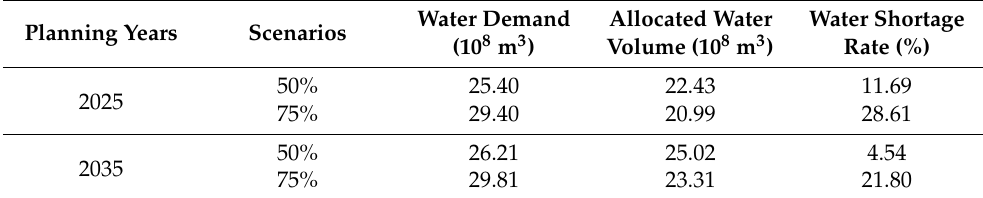
Table 1. The results of optimal allocation of water resources. Planning